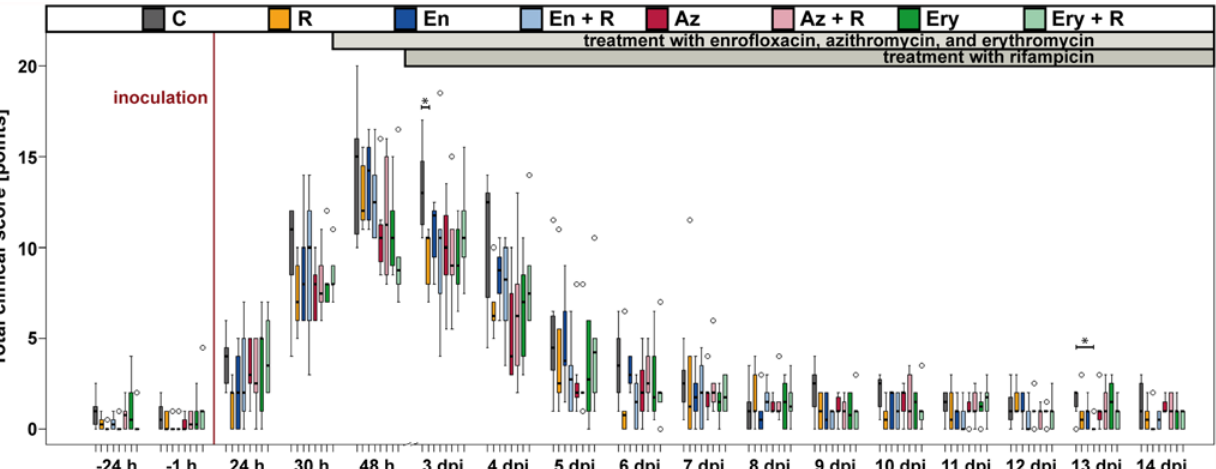
Fig 2. Total clinical score. Following inoculation with Chlamydia psittaci , all animals developed signs of an acute respiratory illness, which were maximal 48 hours to 3 days after inoculation. Regardless of treatment, the total clinical score dropped back to baseline level within seven days the latest. Only on two occasions (3 dpi and 13 dpi) there were differences between treated groups and untreated controls that could be statistically secured. Significant differences to the untreated control group at the same day are indicated with asterisks (many-to-one comparisons by Gao et al . (2008) with Hochberg-adjustment, P (cid:1)